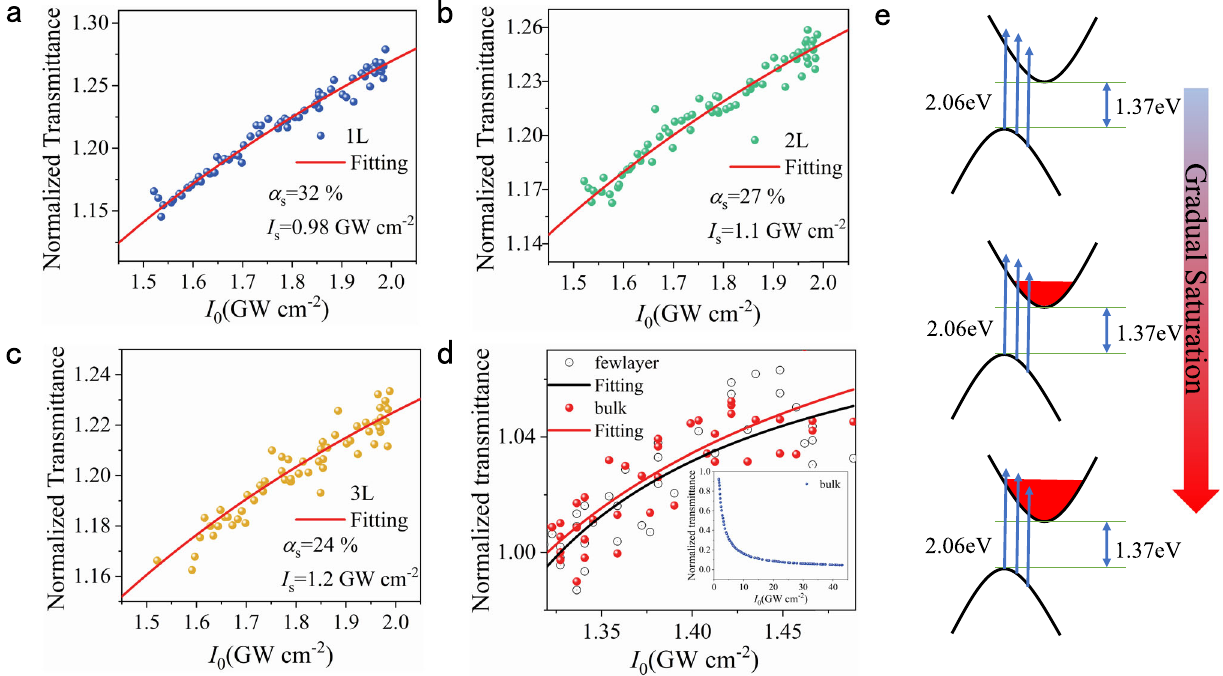
Fig. 6 SA properties of 1 – 3 L and bulk PdSe 2 fl akes. a – c Nonlinear transmittance of 1 – 3L PdSe 2 . The blue, green, and yellow dots represent the experimental data, while the solid red lines show the fi tted results using the SA model. The SA intensities of 1, 2, and 3 L PdSe 2 are 0.98, 1.1, and 1.2GWcm − 2 , respectively. The modulation depths of 1, 2, and 3L PdSe 2 are 32%, 27%, and 24%, respectively. d Nonlinear transmittance of the bulk PdSe 2 . The white and red dots represent the experimental data, while the black and red solid lines show the fi tting curves of few-layer and bulk PdSe 2 using the SA model. The inset shows a reverse SA trend of the thick bulk PdSe 2 with increased laser power. e The electronic transition process of SA. All the above measurements were performed under 600nm